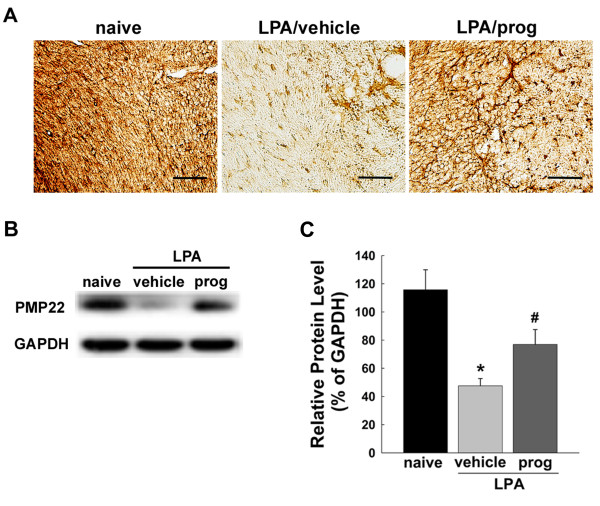
Effects of progesterone treatment (16 mg/kg/day) upon PMP22 expression. (A) Vehicle treatments did not affect the LPA-induced decreases in PMP22 expression in the trigeminal nerve root compared with naïve rats on postoperative day 5. However, decreased PMP22 expression, produced by LPA injection, was recovered following treatment with progesterone. (B) Western blot analysis also showed that LPA suppresses the 19 kDa band for PMP22, which was recovered by treatment with progesterone. GAPDH was used as a loading control. (C) Quantitative analyses of western blotting data. * P < 0.05, naive- vs. LPA/vehicle-treated group. # P < 0.05, LPA/vehicle-treated group vs. LAP/progesterone-treated group. Scale bar, 50 μm.